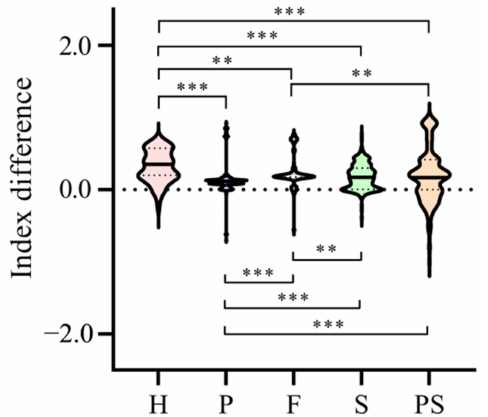
Figure 4. Index difference of each form of capital. (**: p < 0.01, ***: p < 0.001).